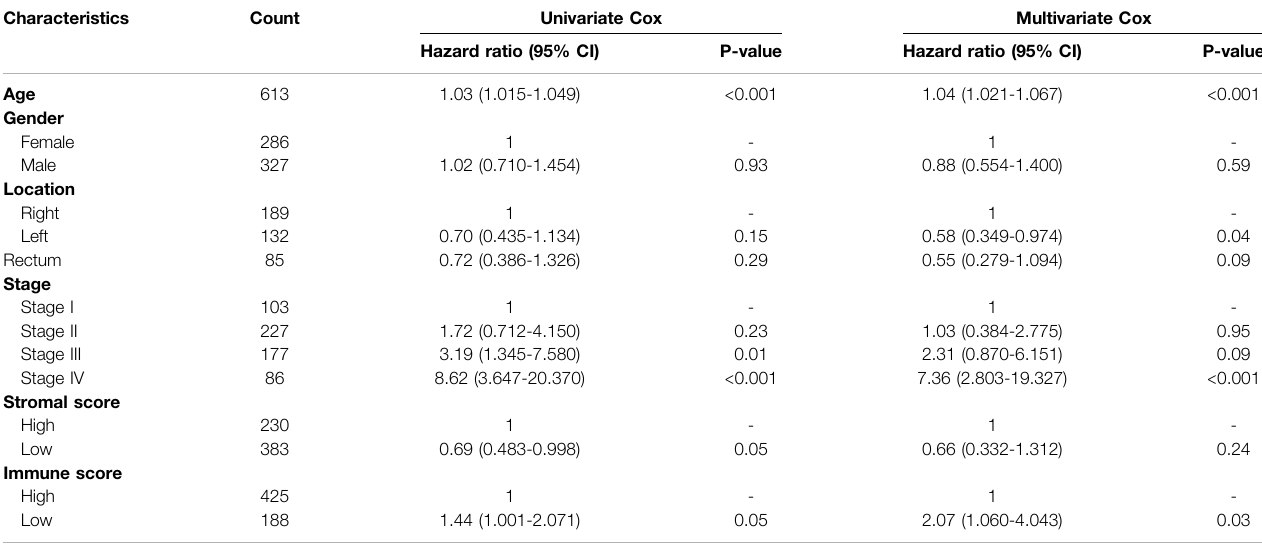
TABLE 1 | Summary and Cox Regression Analysis of overall survival for TCGA CRC study dataset.